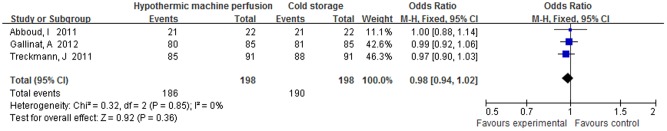
One-year patient survival for ECD kidneys preserved by HMP versus CS.